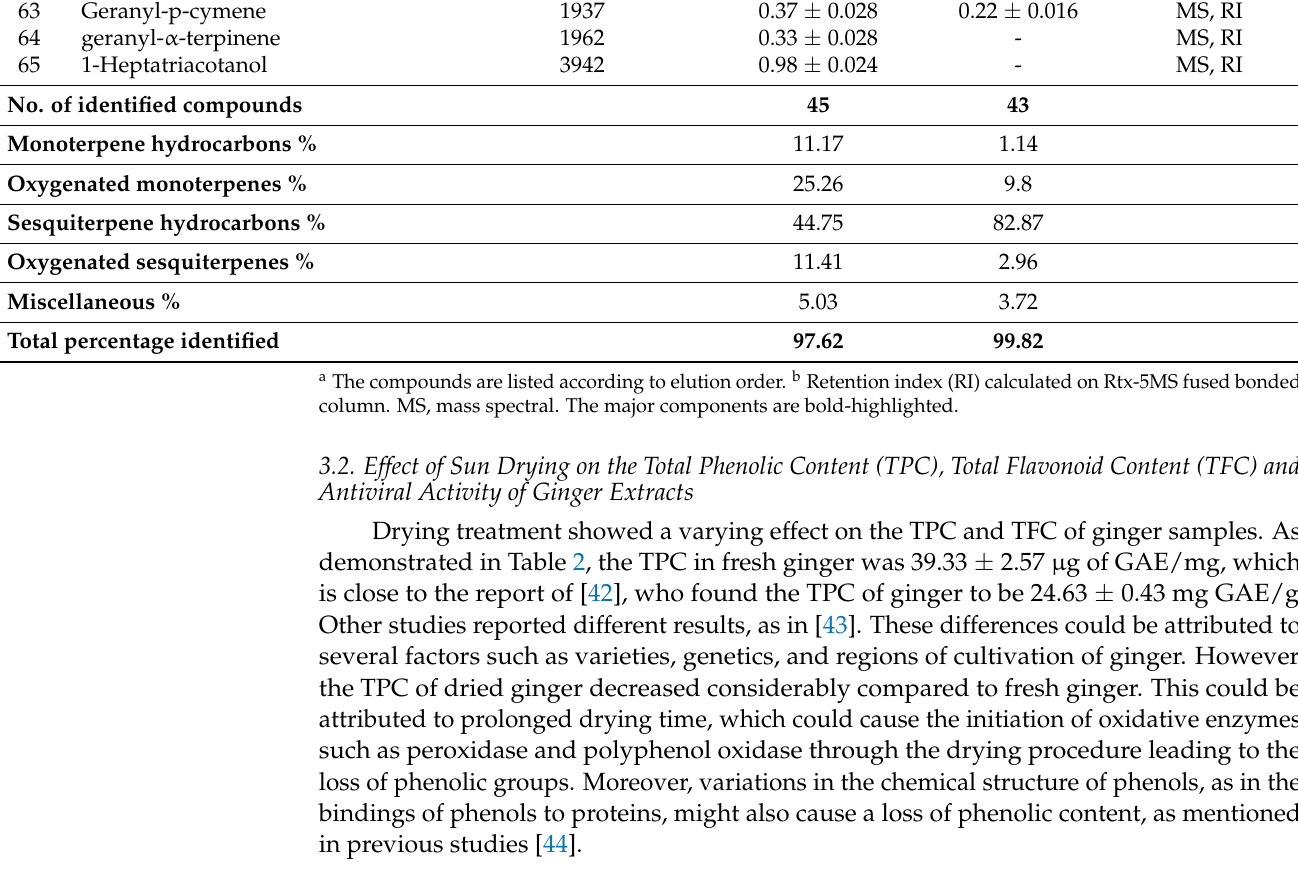
Table 2. Changes of TPC, TFC, and antiviral activity of ginger